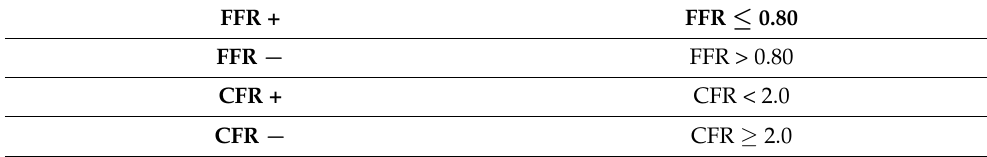
Table 1. Abbreviations of different subgroups determined by FFR and